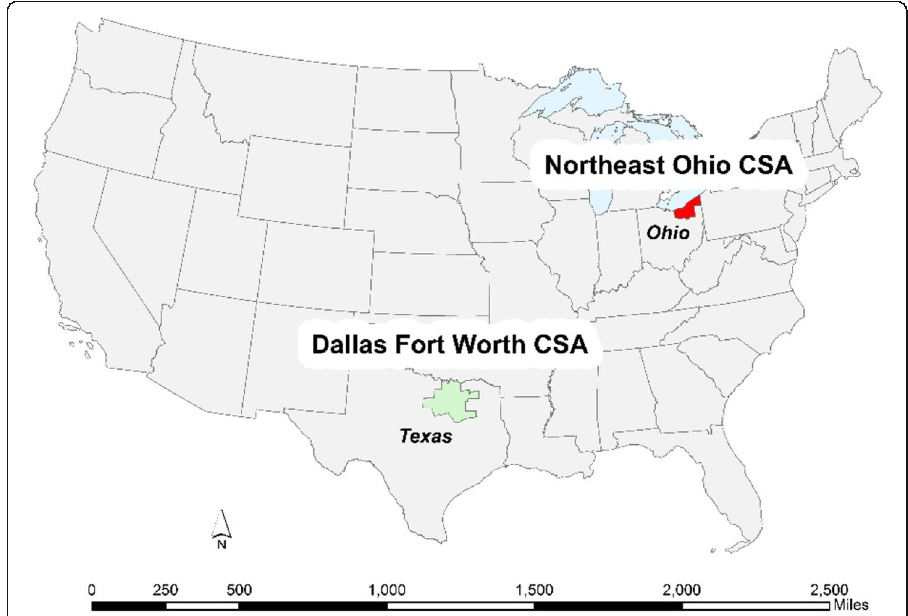
Fig. 1 Location in the United States of the two case studies — Cleveland-Akron-Elyria (NEO, red) and Dallas- Fort Worth (DFW, light green) Combined Statistical Areas